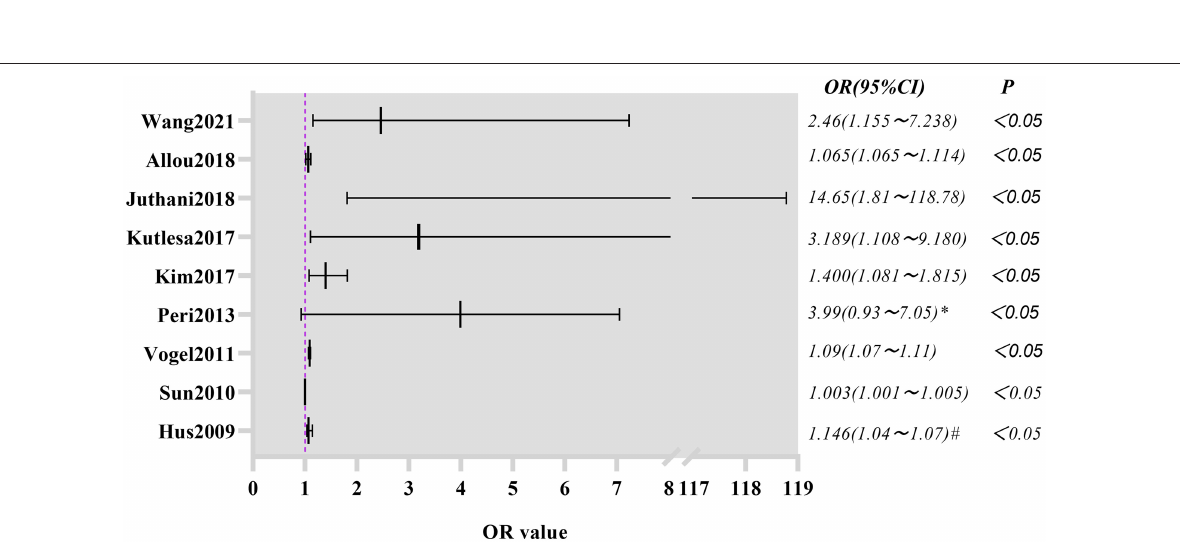
Frontiers in Public Health |